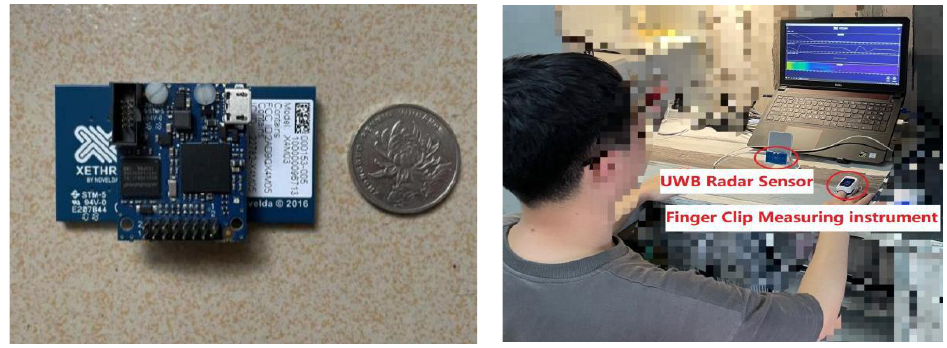
Figure 3. X4M03 module and experiment environment. Table 1. The X4M03 module parameter setting.